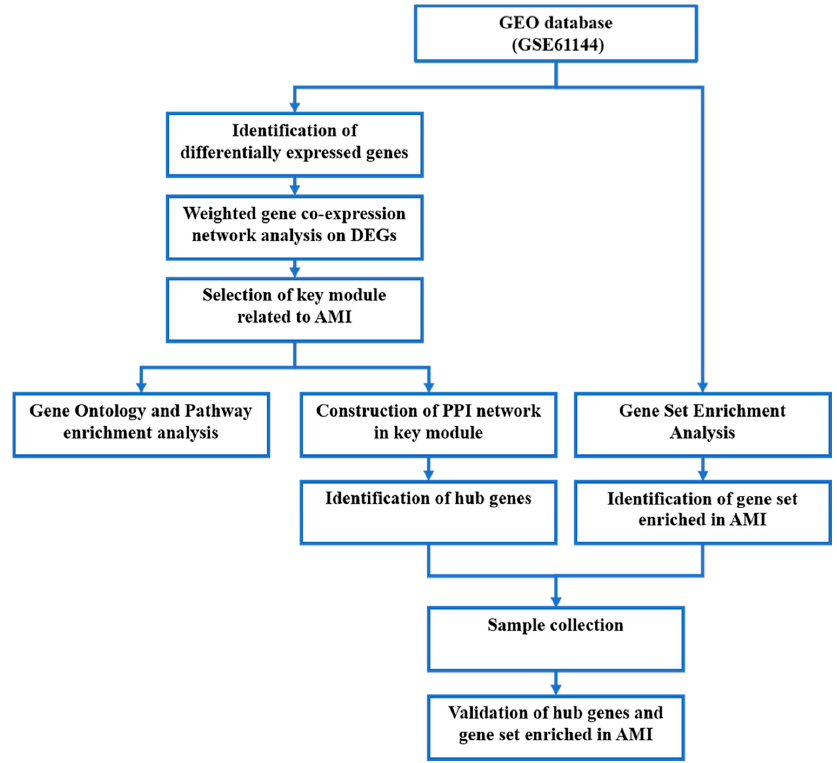
Figure 1. Workflow chart of the present study.